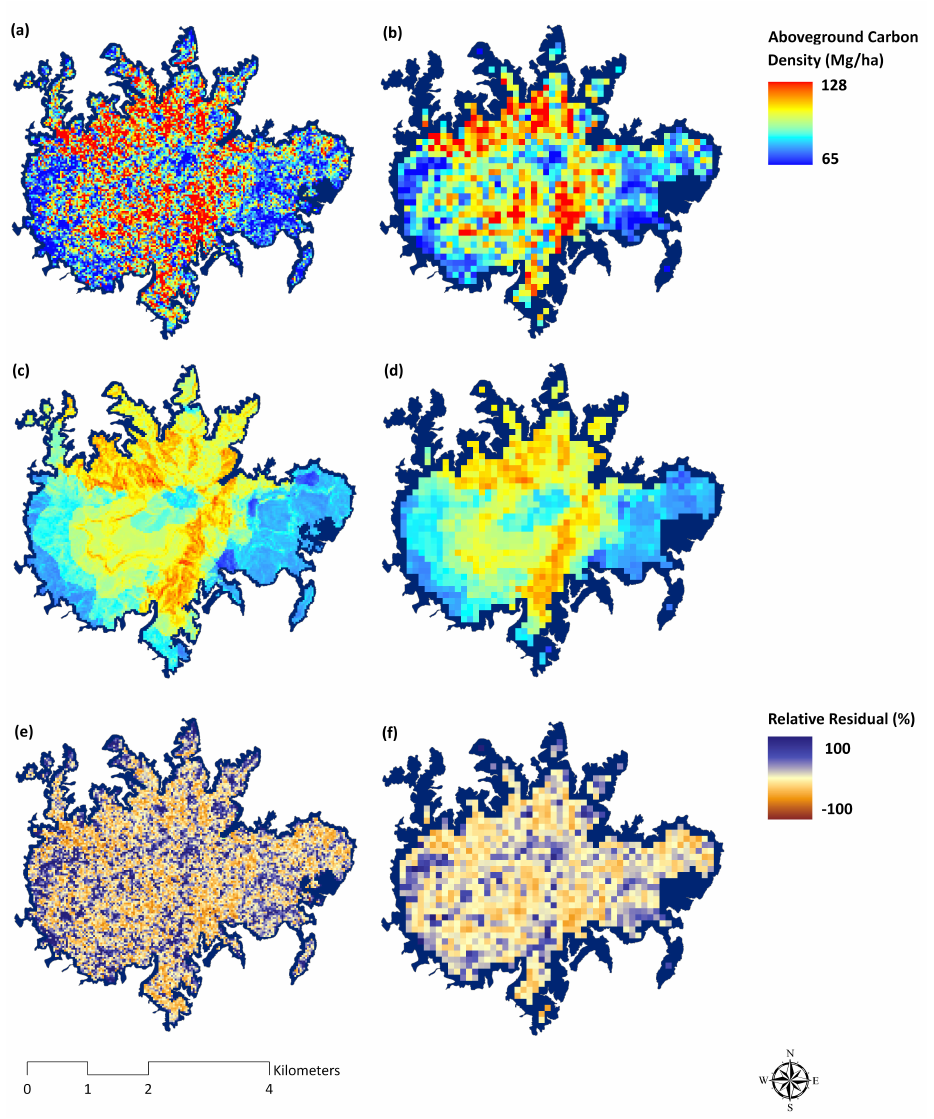
Fig. 4. Observed LiDAR-derived carbon density at (a) 30- and (b) 100-m resolutions, (c, d) carbon density as predicted by multiple linear regression analysis, (e, f) relativized model residuals. The color ramp for carbon density reflects a minimum and maximum of one standard deviation from the mean observed carbon density on BCI (96.5MgCha − 1 )